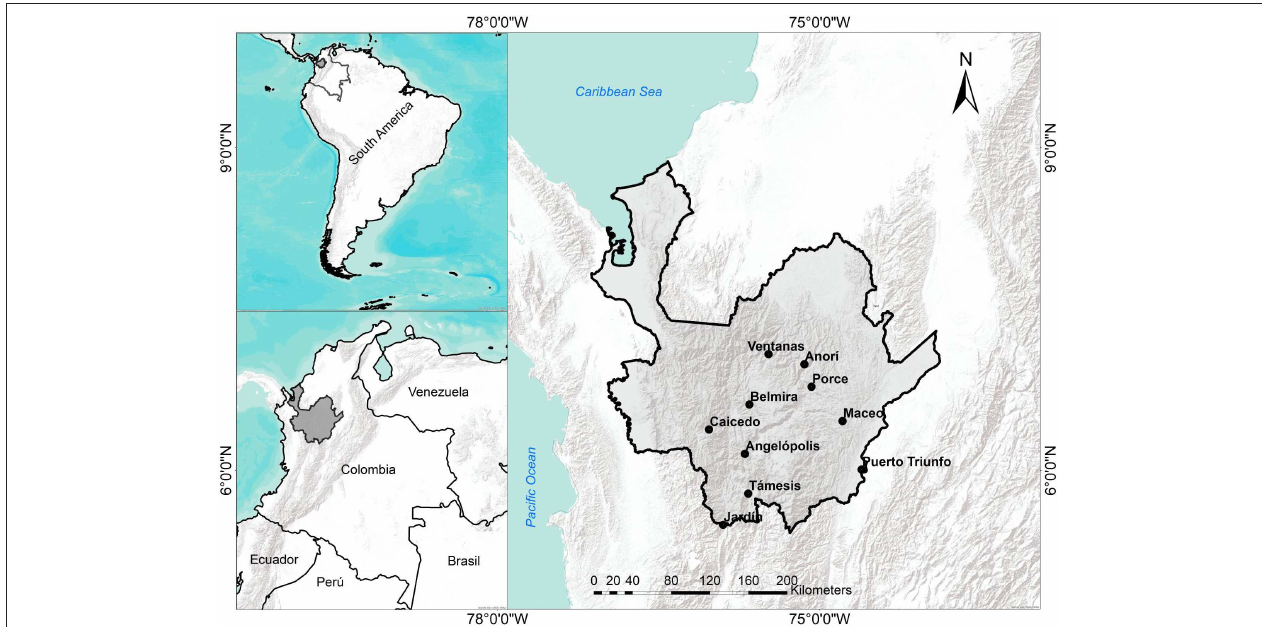
FIGURE 1 | Map of study area showing the locations of the 10 study plots (1-ha each) in the Antioquia department of Colombia. Plot elevations are Puerto Triunfo: 192m; Támesis: 550m; Maceo: 1,024m; Porce: 1,033m; Anorí: 1,794m; Angelópolis: 2,118m; Ventanas: 2,120m; Jardín: 2,550m; Caicedo: 2,635m; Belmira: 2